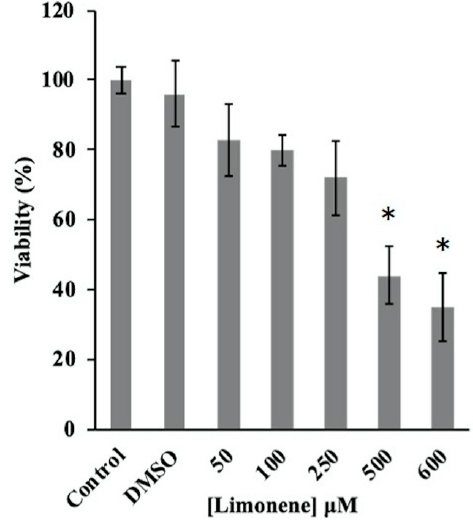
Figure 2. Cell viability of C. albicans was evaluated after 8 h of incubation with 50, 100, 250, 500, and 600 µM of limonene. The growth of treated cultures is shown as the percentage of control cells incubated in medium alone. Viability was determined by a 3(4,5-dimethylthiazol-2-yl)-2,5-diphenyltetrazolium bromide (MTT) assay. * p < 0.05 compared with the control group ( C. albicans ATCC 90028 without treatment; ANOVA with post-hoc Tukey’s test).